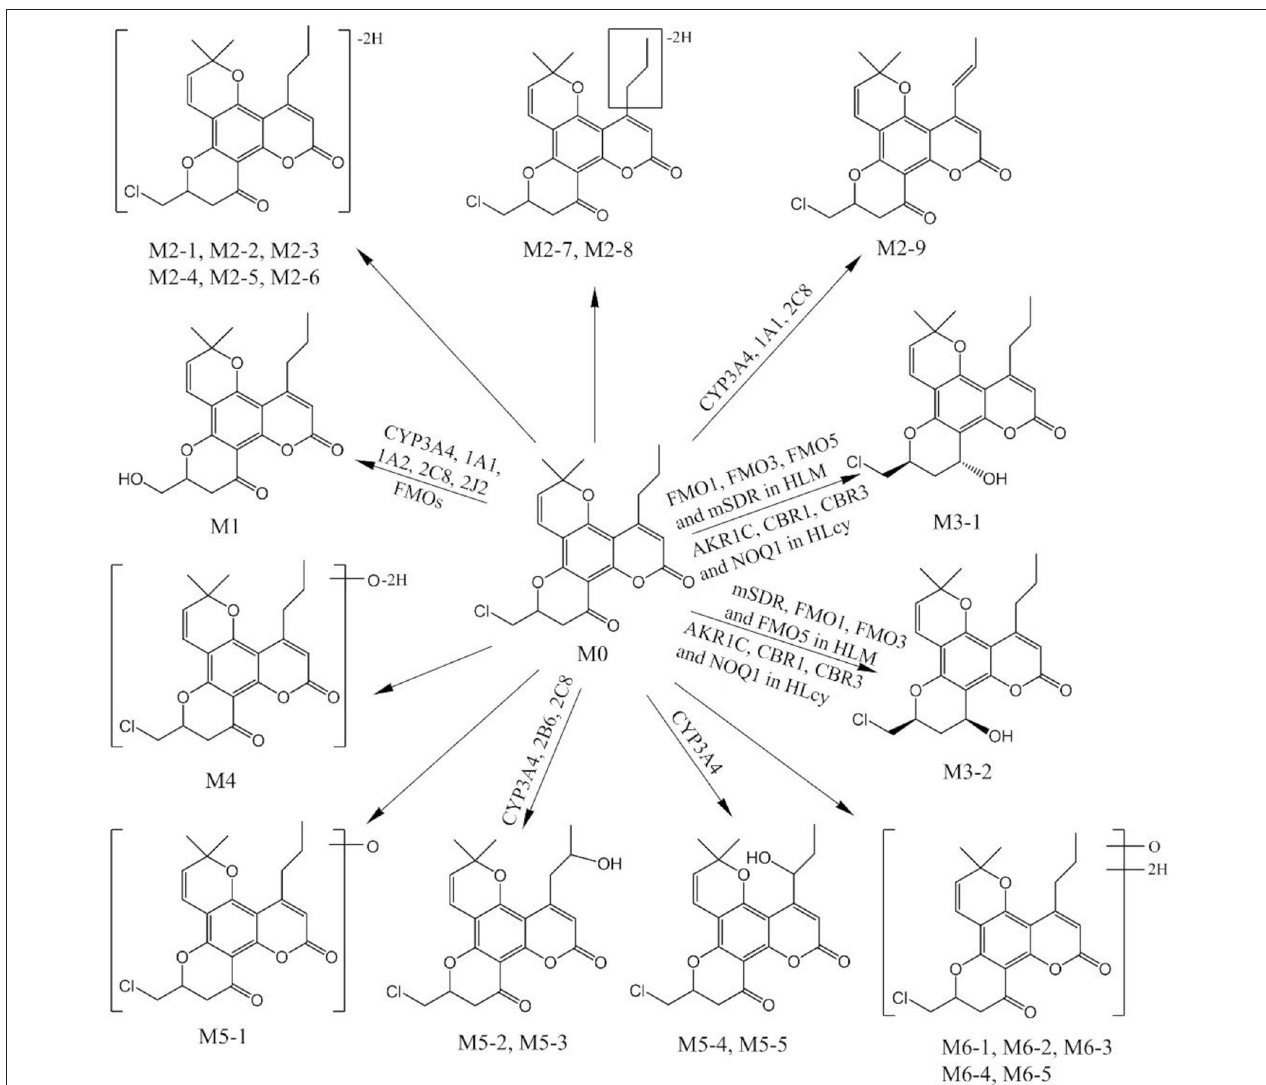
FIGURE 8 | Proposed metabolic pathway of F18 in